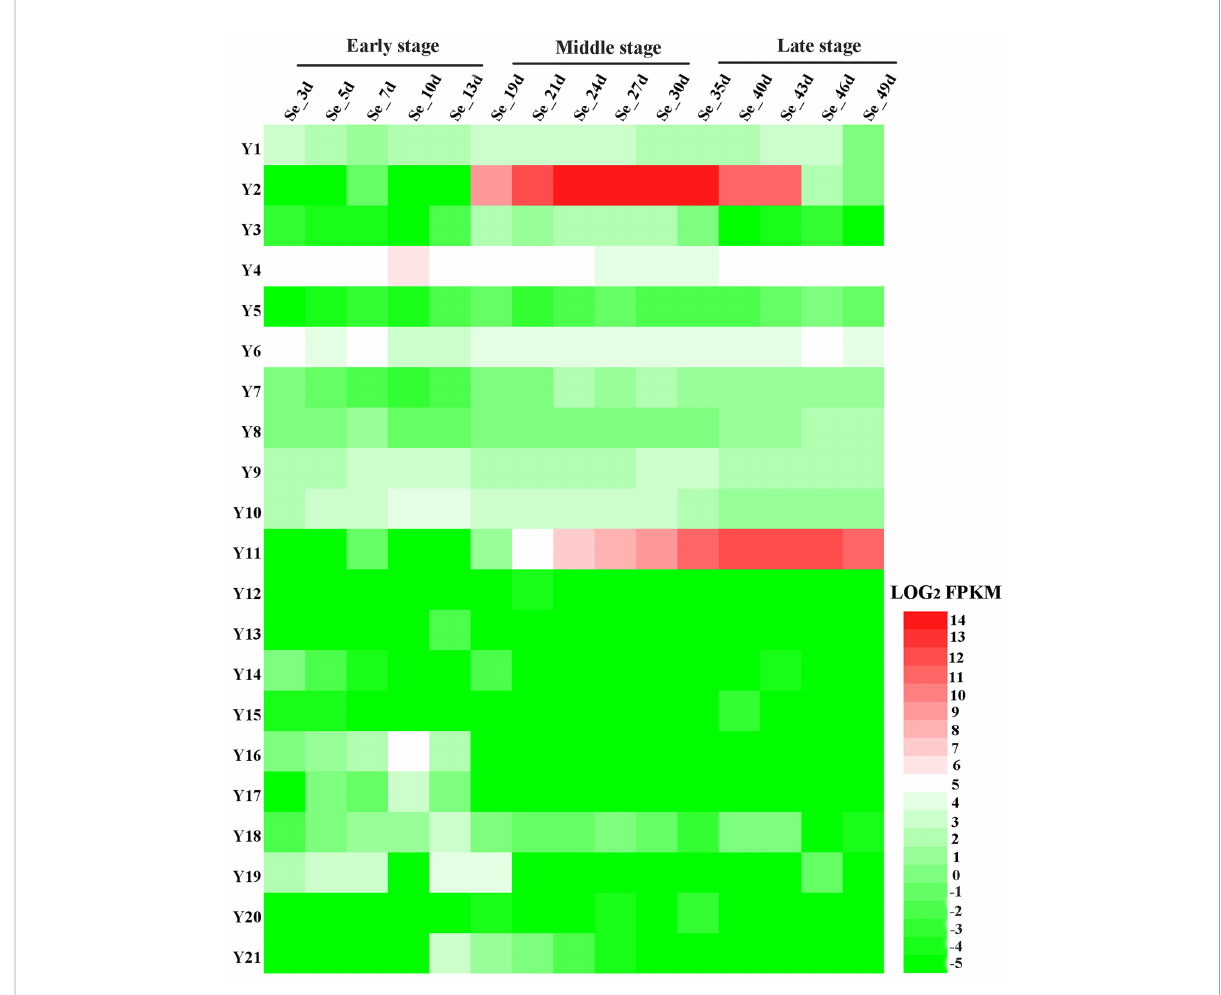
FIGURE 4 Expression patterns of 21 candidate genes in seeds at different developmental stages in B. napus . Se - 3d, 5d, 7d, 10d, 13d, 19d, 21d, 24d, 27d, 30d, 35d, 40d, 43d, 46d, 49d represent seeds from B. napus ZS11 , collected on the indicated number of days after pollination. The heatmap was drawn using Heatmap Illustrator (HemI) (Deng et al., 2014). The bar on the lower right corner represents LOG 2 FPKM; green and red represent low and high expression levels,